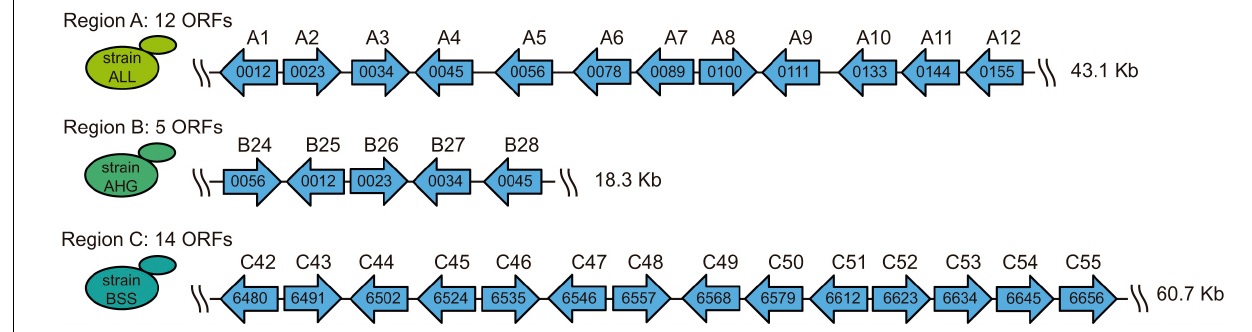
Frontiers in Genetics |